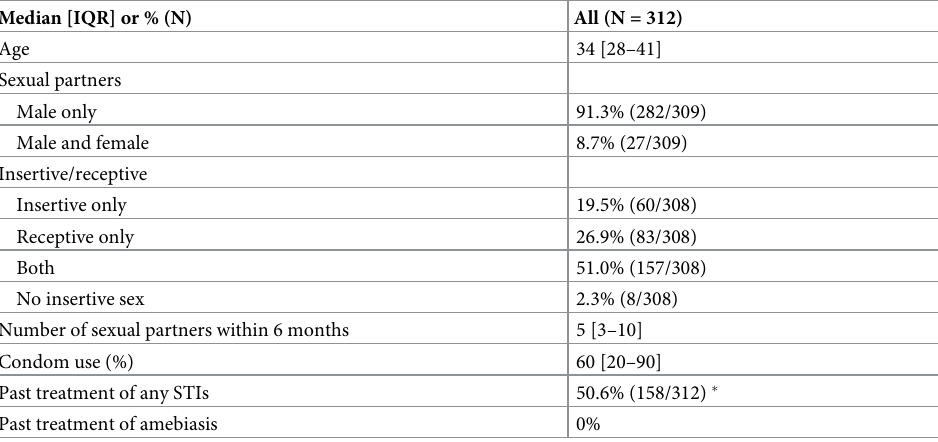
Table 1. Characteristics of study participants undergoing a screening test for anti- E . histolytica antibody. Median [IQR] or %